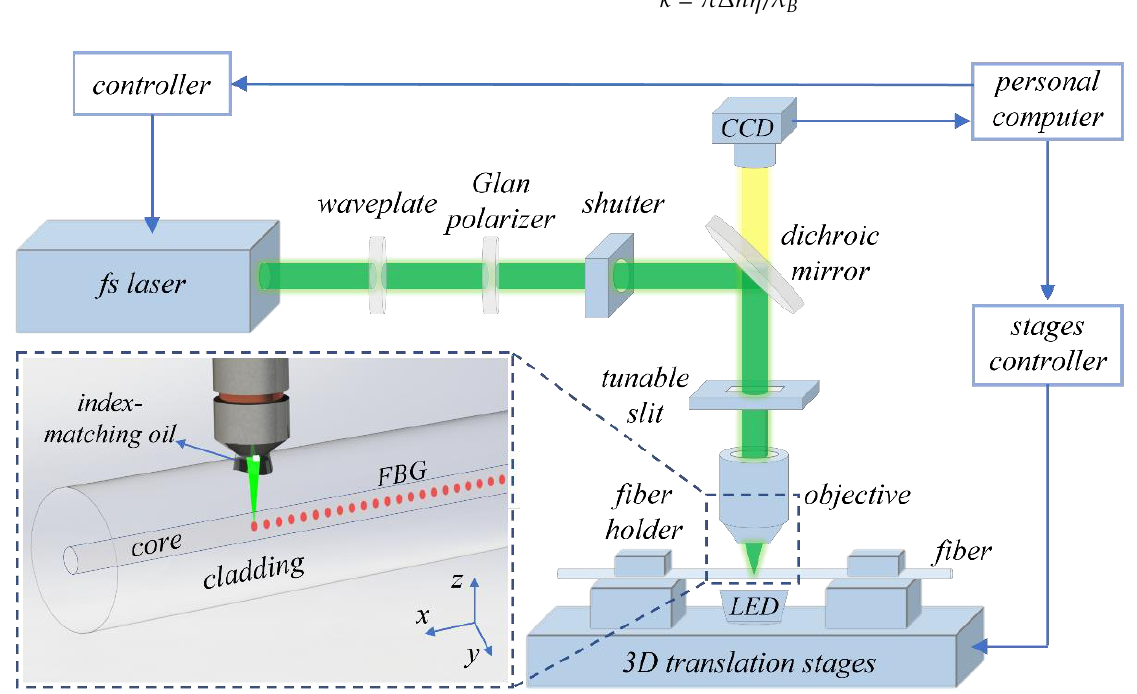
Figure 1. Experimental setup for inscribing FBG using fs laser PbP technology. The coupling strength coefficient κ and insertion loss (IL) of an PbP FBG are largely dependent on the size, shape and morphology of the refractive index modulations (RIMs) in the fiber core. The ∆ n is the amplitude (or AC component) of the RIM, which